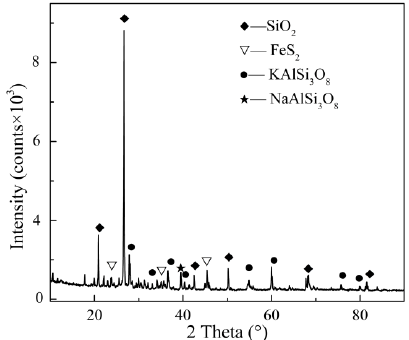
Figure 4. XRD pattern of cyanide tailings.